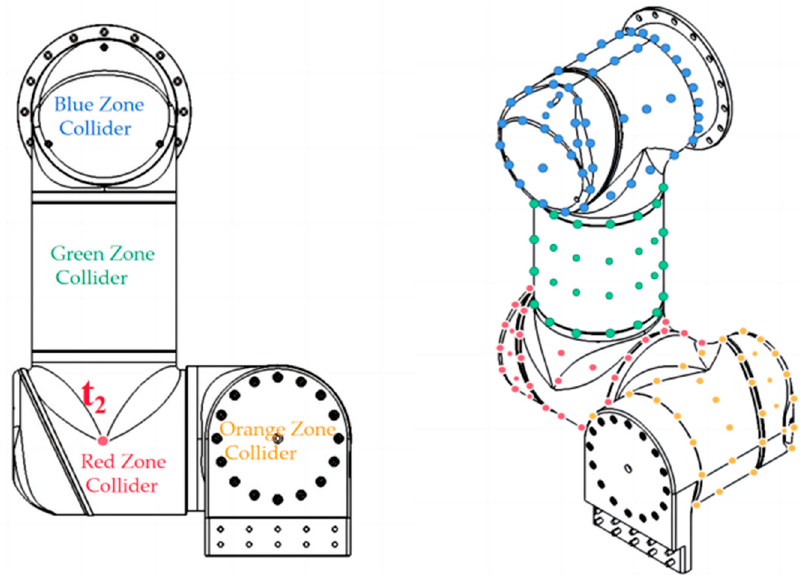
Figure 5. The point set of RF colliders.